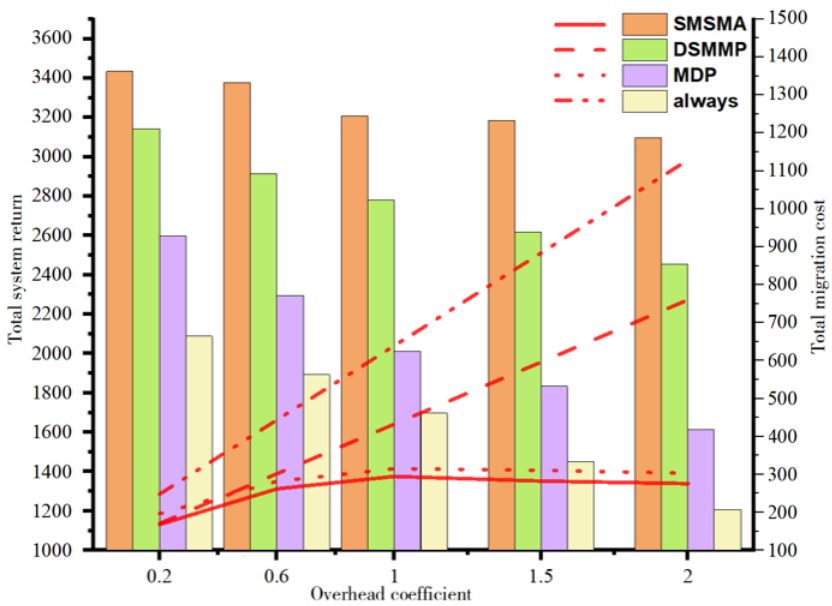
Figure 8. Effect of overhead factor on total return versus system overhead.